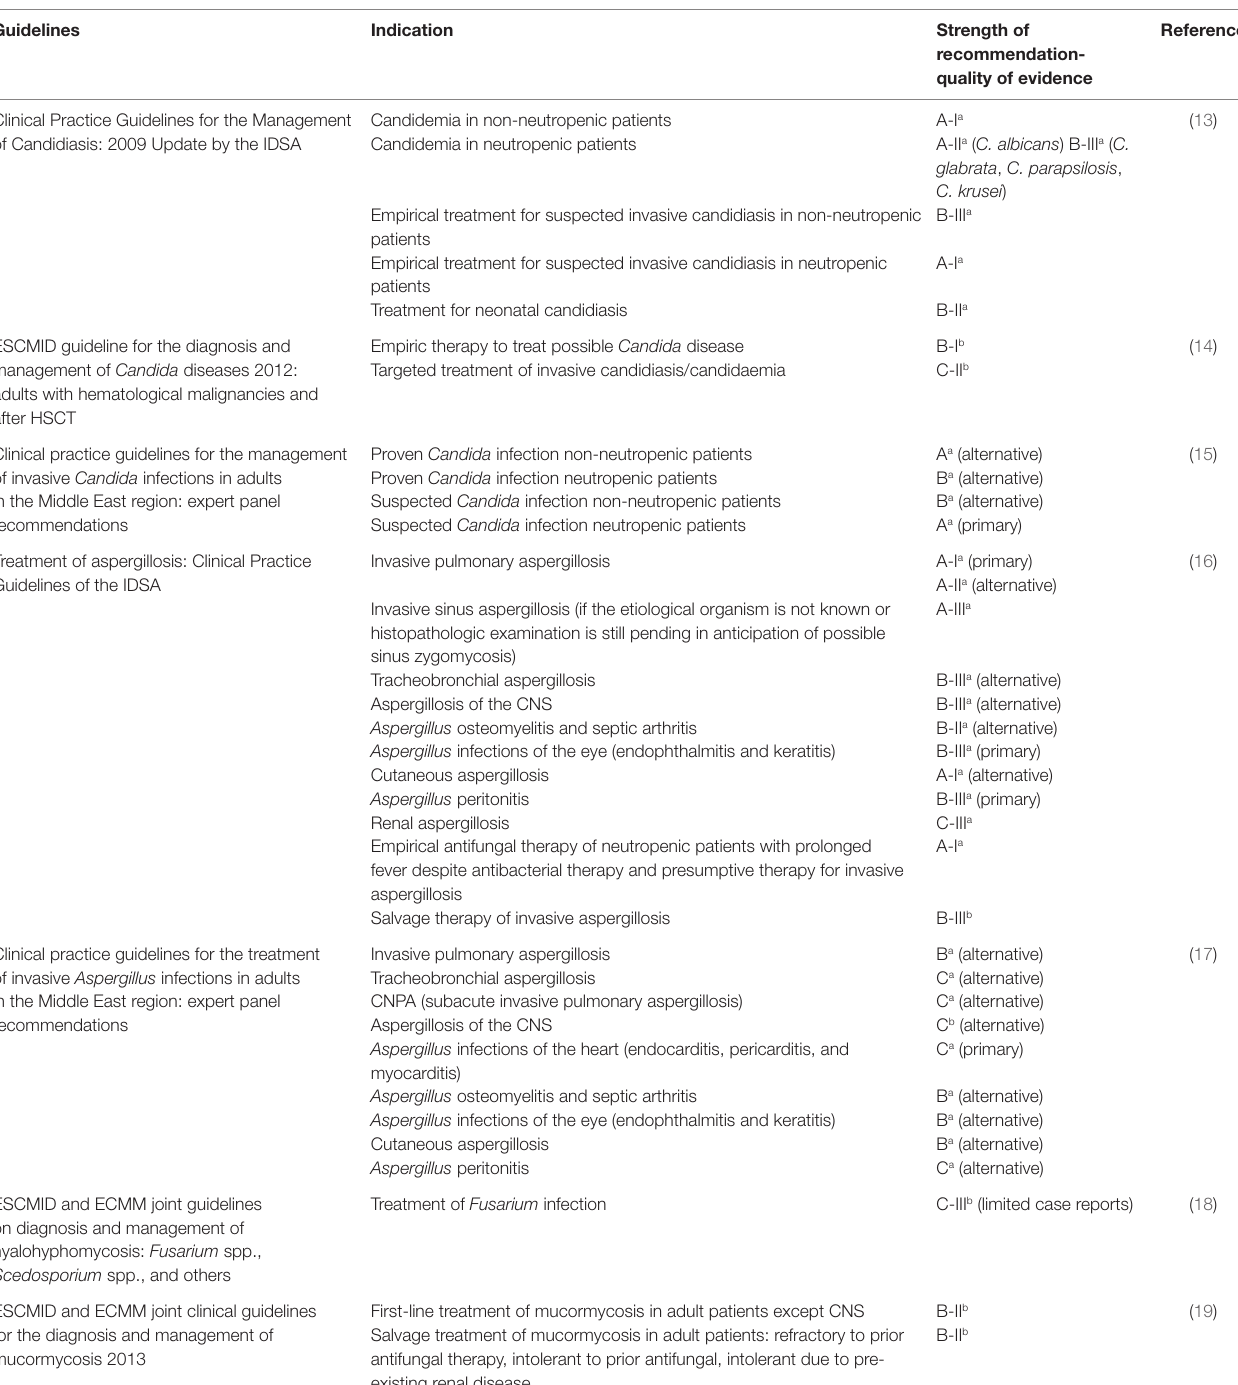
TaBle 1 | summary of recommendations for the use of amphotericin B lipid complex (aBlc) or other lipid formulations in the management of invasive fungal disease according to regional and international